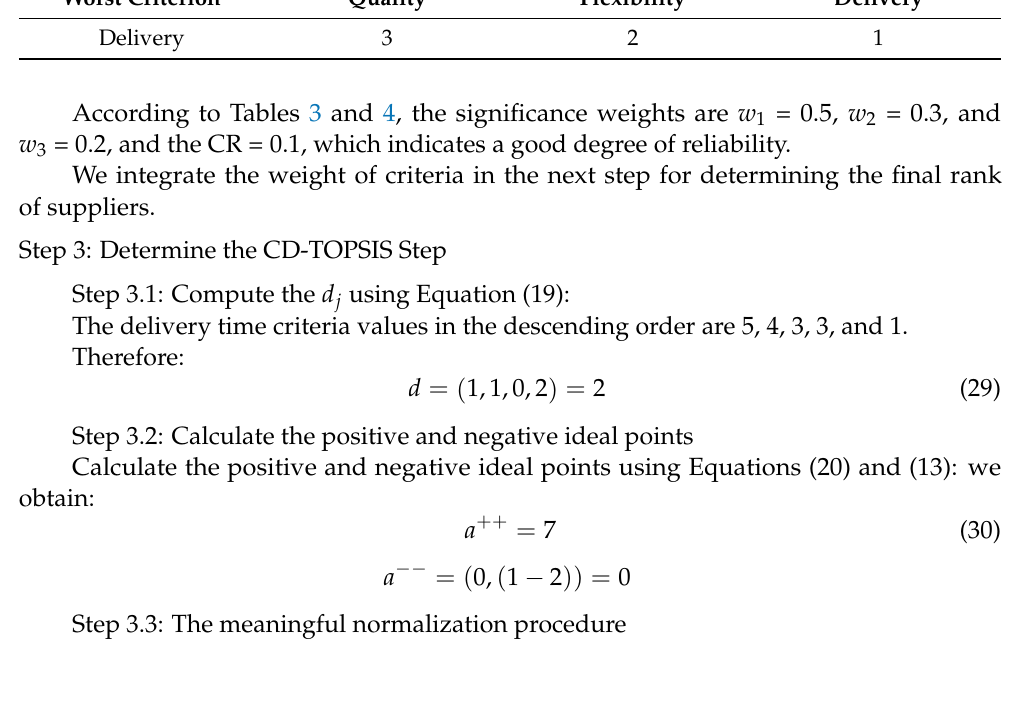
Table 4. The DM Preferences (Worst Criterion). Worst